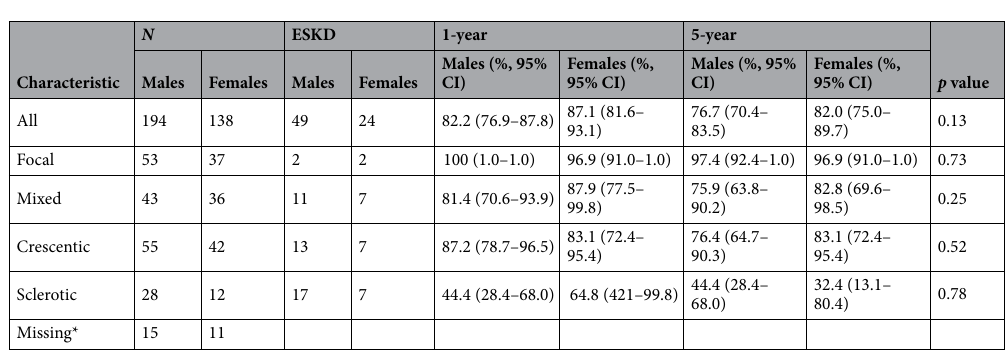
Table 2. Renal survival at 1- and 5-years follow-up, stratified by gender and Berden classification. *Berden histological class missing in n =